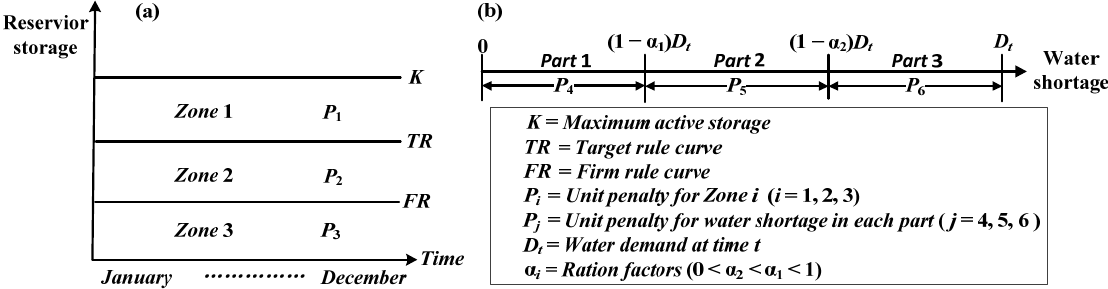
Figure 2. The penalty structure: ( a ) penalty structure based on reservoir zone and ( b ) penalty structure for water shortage based on demand during rationing.